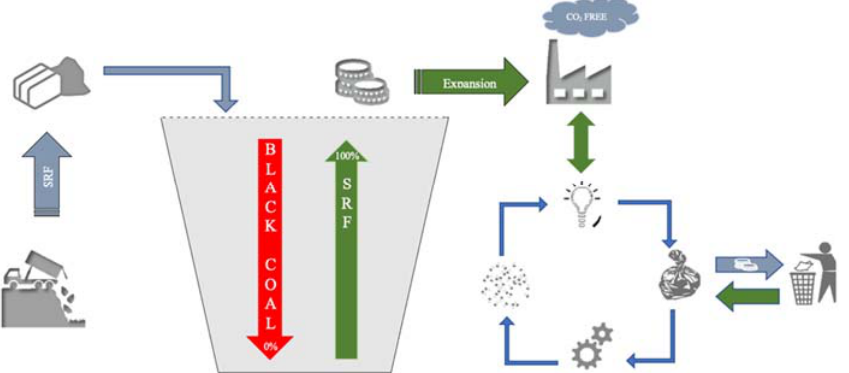
Figure 5. Proposed solution for Vojany black coal power plant based on study results. Source: Own processing.